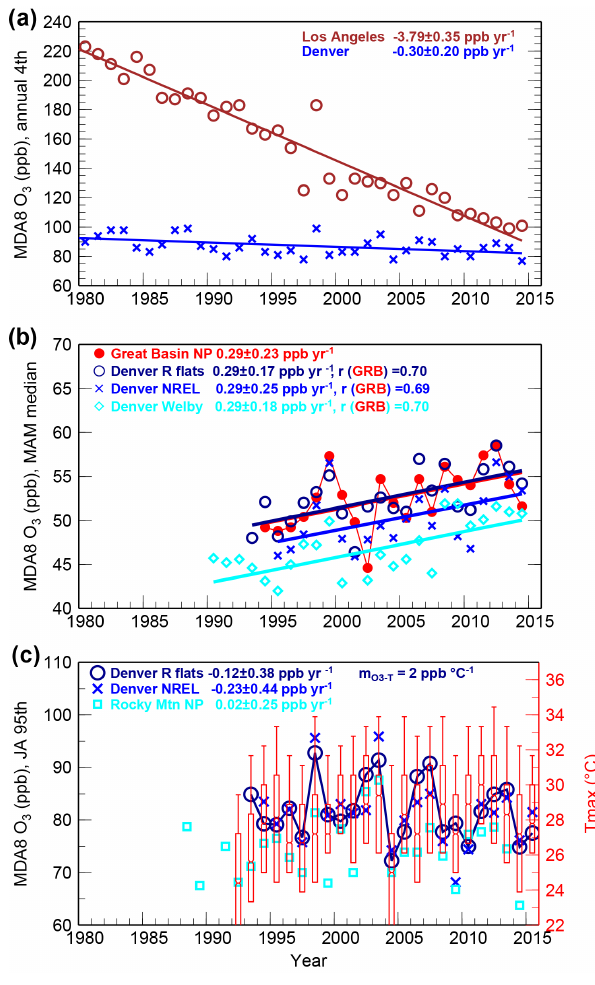
Figure 17. Surface O 3 trends in Denver. (a) Comparison of ob- served trends in annual fourth highest MDA8 O 3 at Crestline Los Angeles (brown) and in Denver (blue, computed from all monitors available in Denver non-attainment counties). (b) Time series of observed median MAM MDA8 O 3 at Great Basin National Park (red), in comparison with three monitors in Denver. (c) Time se- ries of observed 95th percentile July–August MDA8 O 3 in Denver, together with statistics (25th, 50th, 75th, 95th) of observed July– August daily maximum temperature at Rocky Flats (red, right axis).